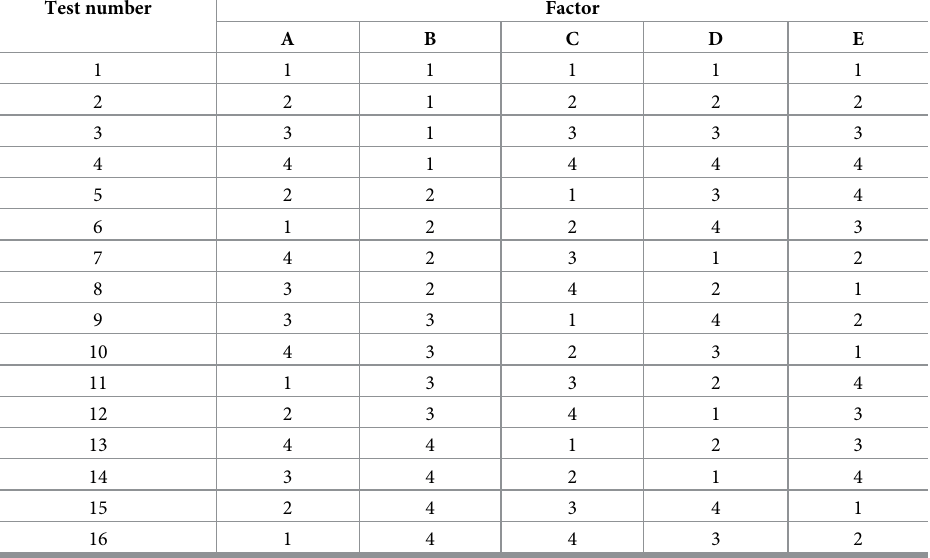
Table 2. L 16 (4 5 ) test